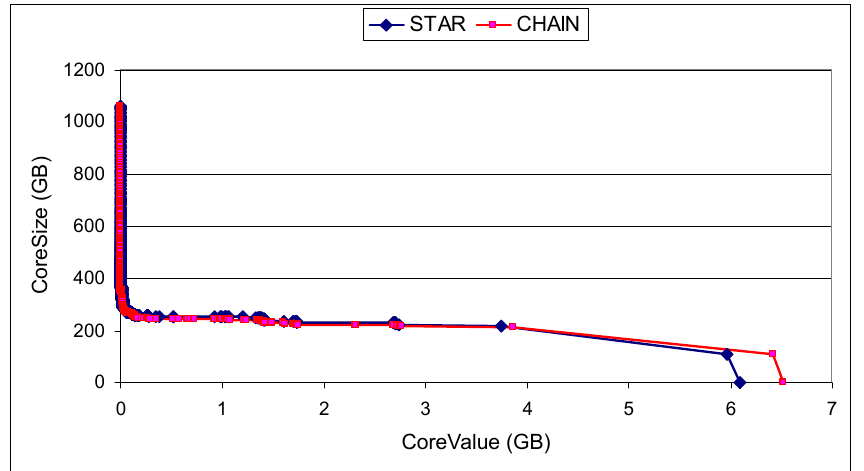
Figure 10. The k-cores and their (deduplicated) size for WL2 workload using CHAIN and STAR